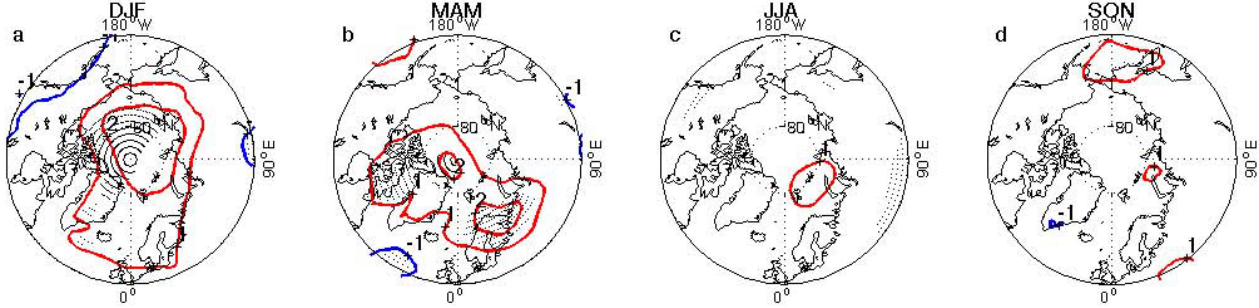
Fig. 12. Sea level pressure difference, in hPa, due to light-absorbing particles in snow and sea ice for each season (positive in red and negative in